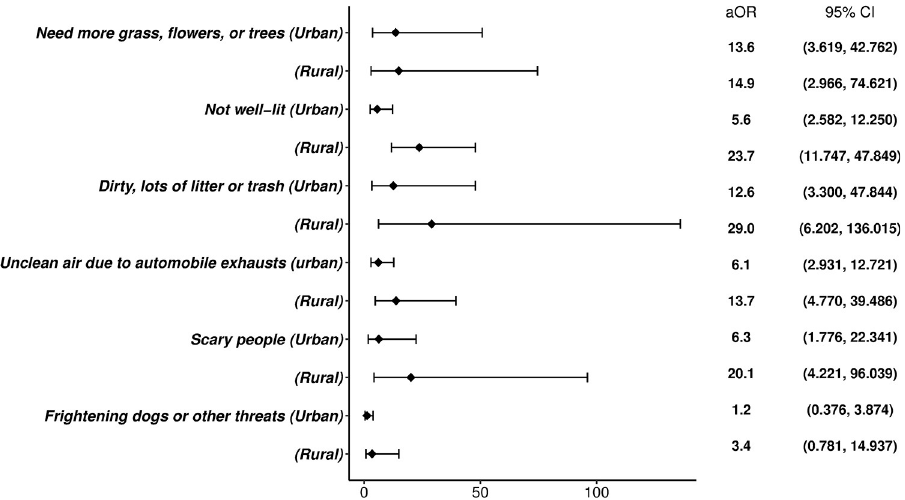
Fig 1. Comparisons with adjusted odds ratios of walking activity comfort factors. aOR, adjusted odds ratio; CI, confidential interval.